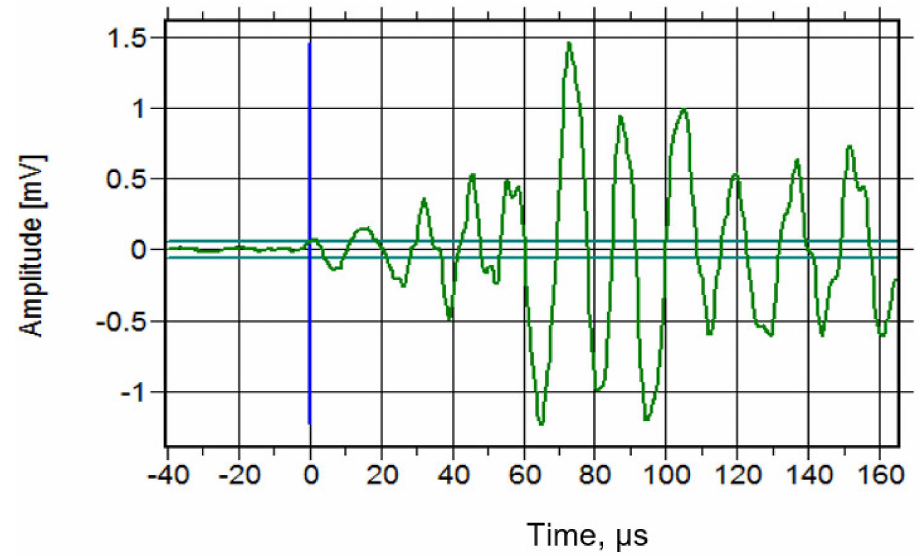
Figure 16. The transient wave at the highest energy.